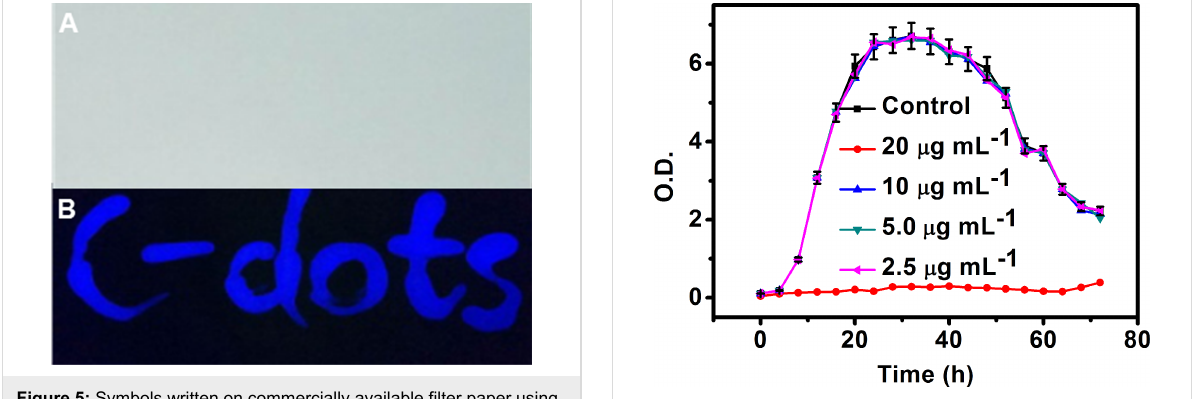
Figure 5: Symbols written on commercially available filter paper using S b (5.0 μ g mL − 1 ) captured under (A) daylight and (B) UV irradiation of λ ex =365 nm.